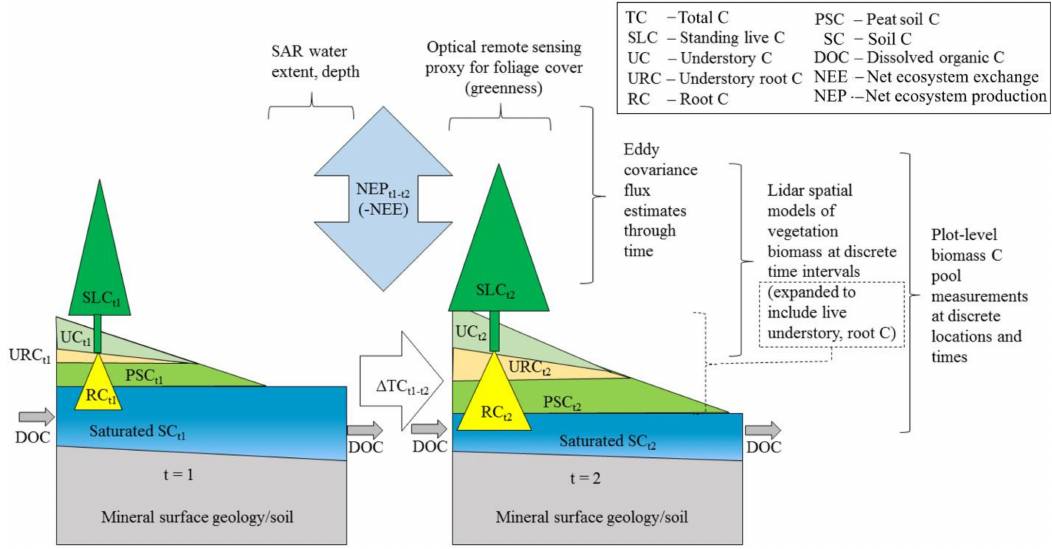
Figure 4. Schematic of carbon pool changes over time with succession / lowering water table and remote sensing measurements for boreal peatlands. Adapted from [347] (for forested